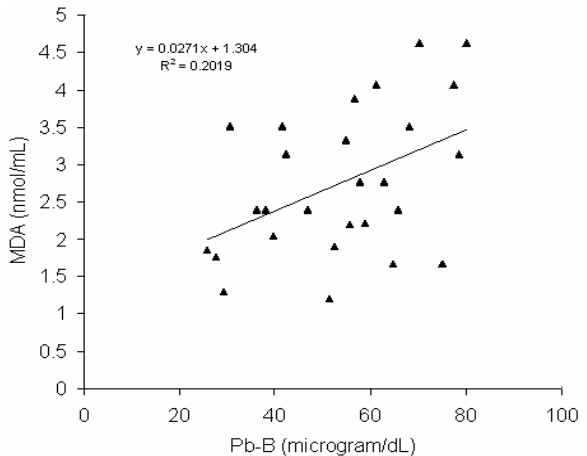
Figure 6: Relationship between blood lead concentration ( Pb- B; range is 25.8 – 78.5 µg/dl) and serum malondialdehyde (MDA) level of lead exposed battery manufacturing workers(BMW)group of western Maharashtra (India );n = 28, Correlation coefficient (r) is 0.45, p< 0.02; y = 0.0271x + 1.304.